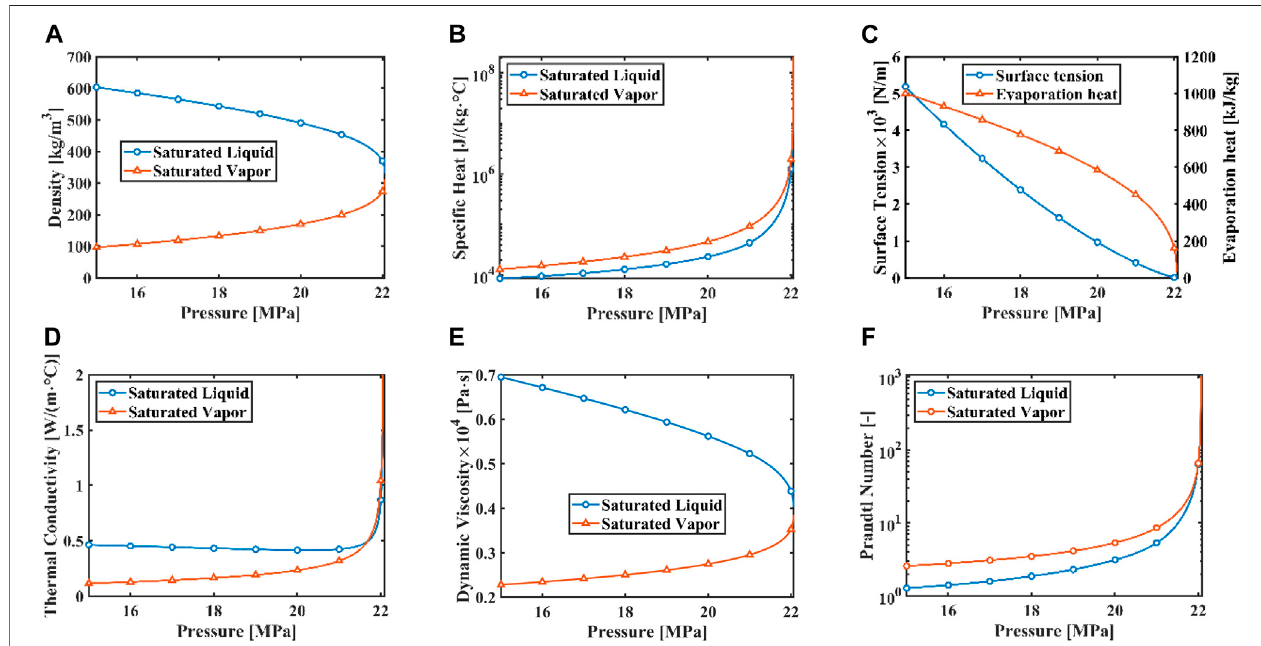
FIGURE 2| Variation ofsaturated propertiesfor water (Lemmon et al., 2007). (A) Density. (B) Speci fi cheat. (C) Surfacetension and evaporation heat. (D) Thermal conductivity. (E) Dynamic viscosity.